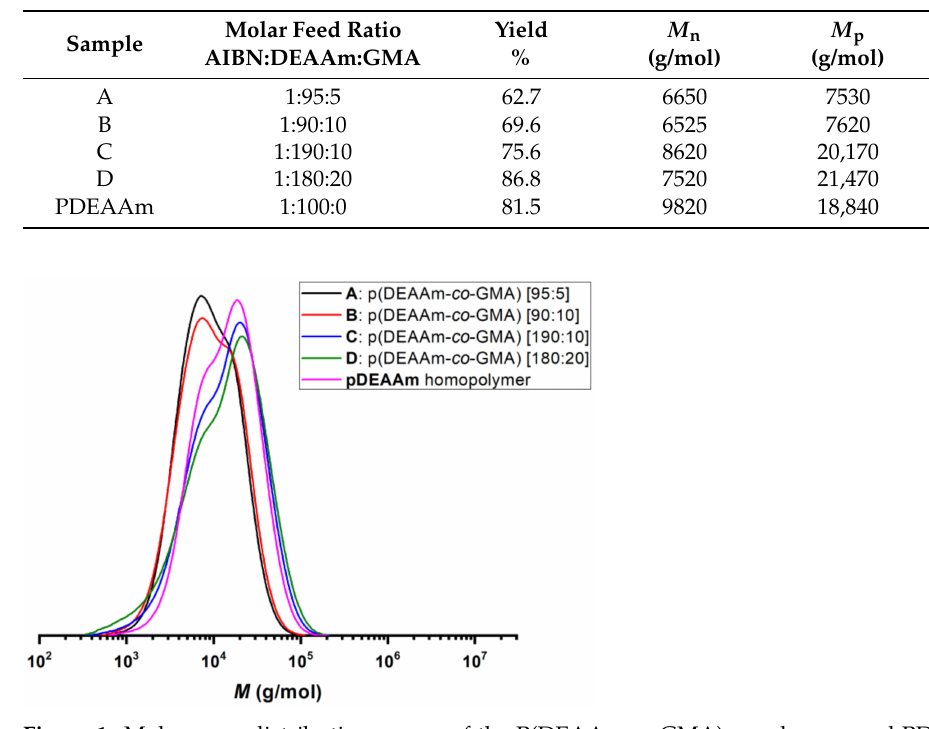
Table 1. Yields and GPC results of the PDEAAm homopolymer and P(DEAAm- co -GMA) copolymers.